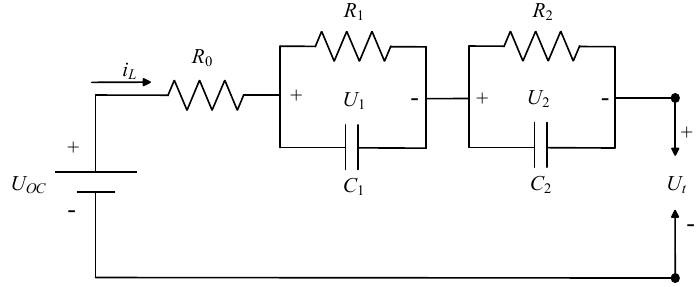
Figure 1. Diagram of the second-order resistor–capacitor equivalent circuit model.